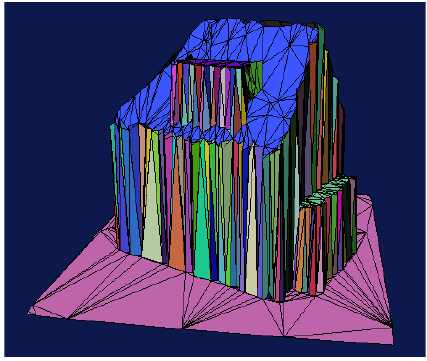
Fig. 6. The result of TIN simplification (cf. Fig. 5) followed by TIN segmentation